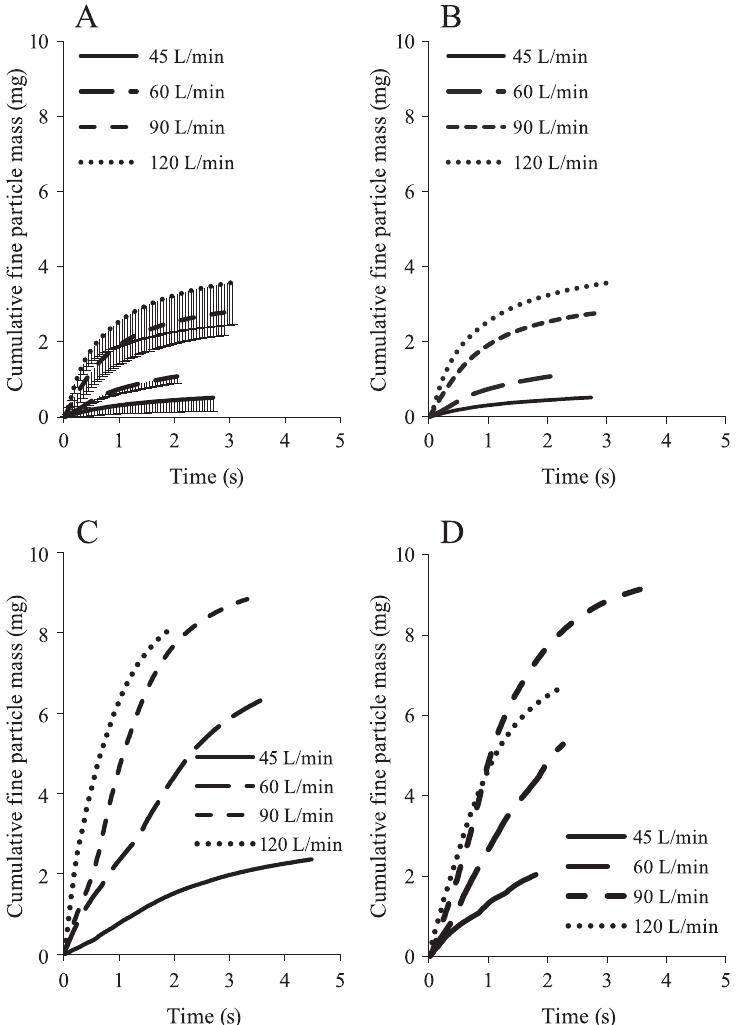
Fig. 3 Cumulative fine particle mass versus time profiles for salbutamol sulphate (SS) powders emitted from the Rotahaler ® aerosolised at 45, 60, 90 and 120 L/min ( n = 5). Uncoated SS shown with error bar represent - ing standard deviation (A), and without error bar (B); 2 % (w/w) magnesium stearate (MgSt) coated SS batch 1 (C) and batch 2 (D) without error